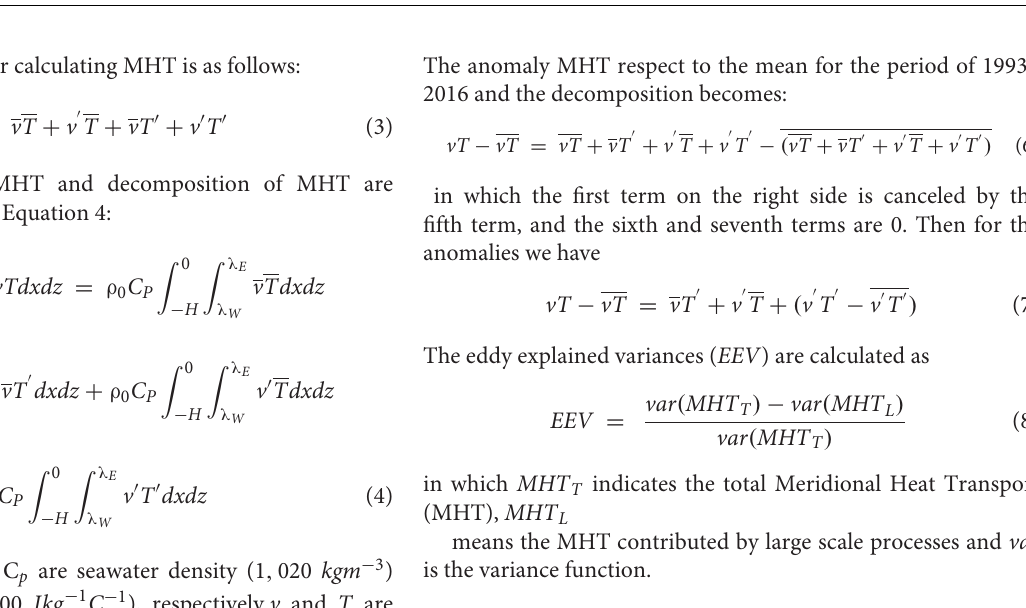
FIGURE 4 | Total mean meridional heat transport ( vT , black lines) and decomposition ( vT blue lines and v (cid:48) T (cid:48) red lines) in G4 (dashed lines) and G12 calculated with 5-day